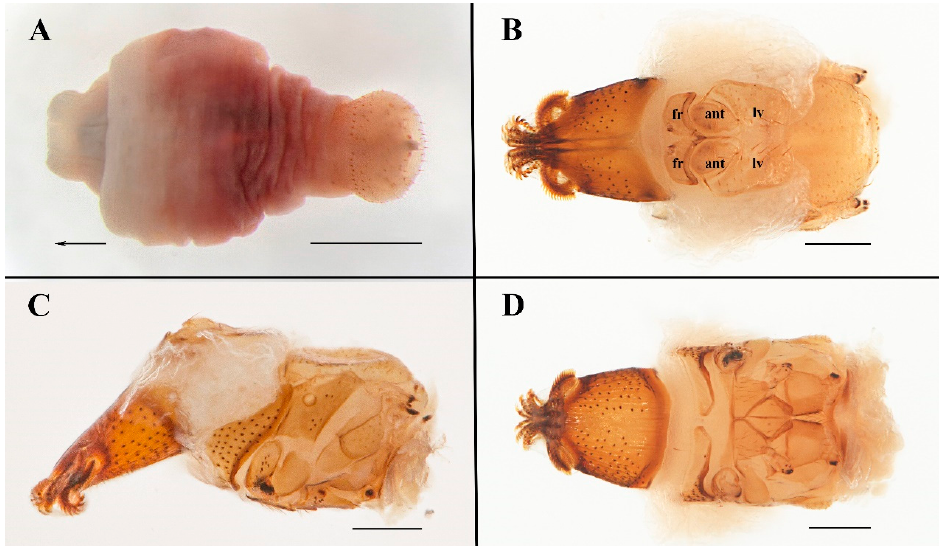
Figure 2. Ascodipteron guoliangi sp. nov., ex. Coelops frithii , China. ( A ). Whole neosome (head and thorax fully withdrawn, arrow indicates direction of the head) (BFU-2434, neosome holotype). ( B – D ). Head and thorax; dorsal view (BFU–2437, neosome paratype) ( B ), lateral view ( C ), and ventral view ( D ). Abbreviations: ant—antenna; fr—frons; and lv—lateral vertex. Scale bars: A = 500 µ m; B , C = 200 µ